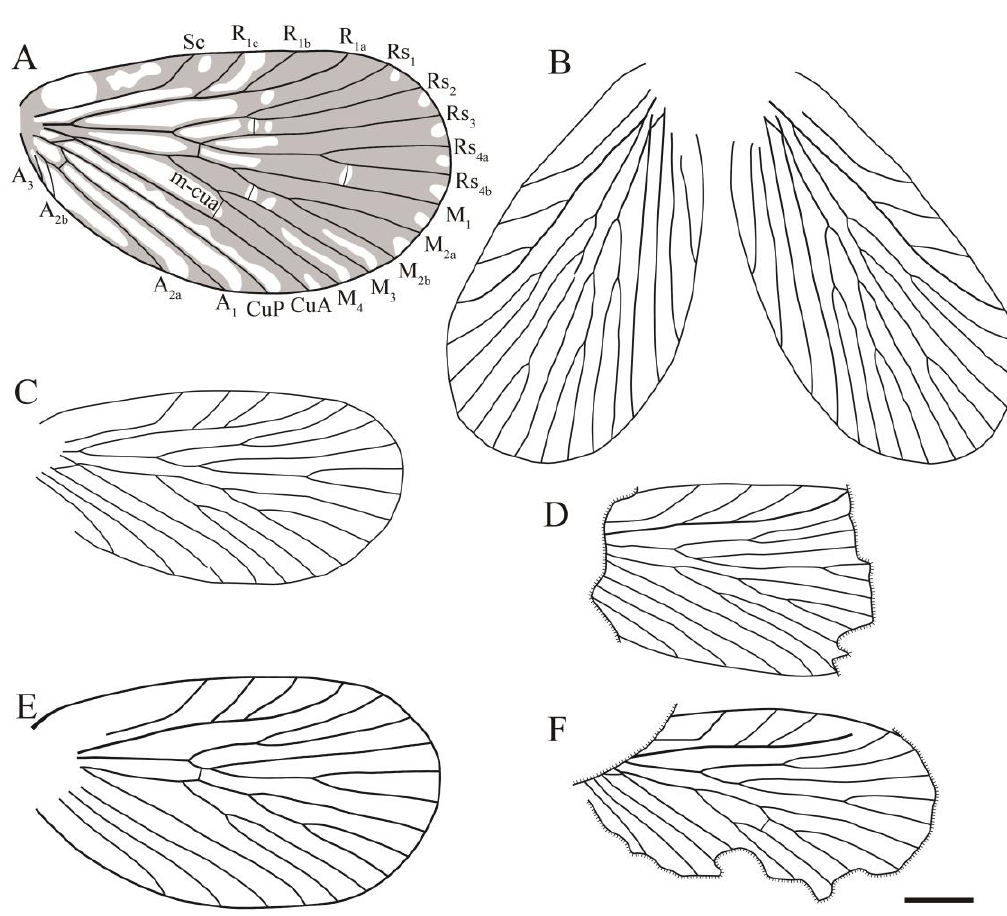
Figure 17. Hind wings of Sinoagetopanorpidae fam. nov. ( A , B ) Photographs of NIGP200930; ( C , D ) Photographs of NIGP200931; ( E ) Photograph of a pair of hind wings (NIGP200932); ( F ) Photograph of NIGP200933; ( G ) Photograph of NIGP200934 (mirror image); ( H ) Photograph of a NIGP200935; ( A , C , E – G ) were taken when specimens were immersed under 70% alcohol in vertical reflected light; ( B , D , H ) were taken in oblique reflected light. Scale bars represent 1 mm in ( A – H ).